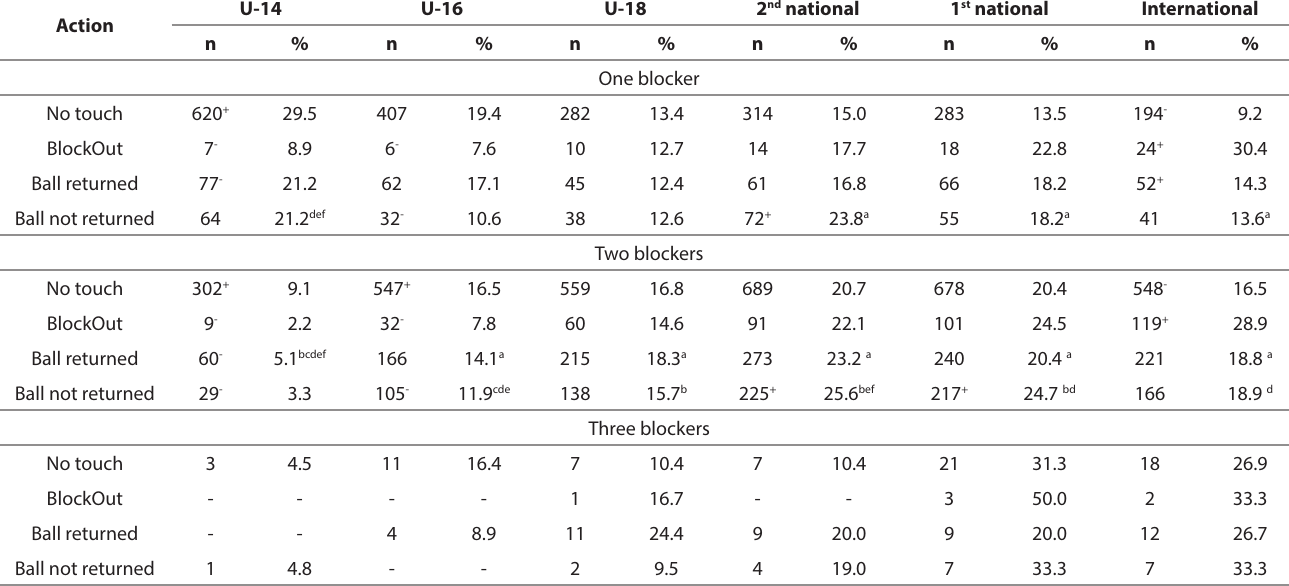
TABLE 6. Efficiency of the block according to the number of hands blocking and levels of competition (women’s volleyball) Action